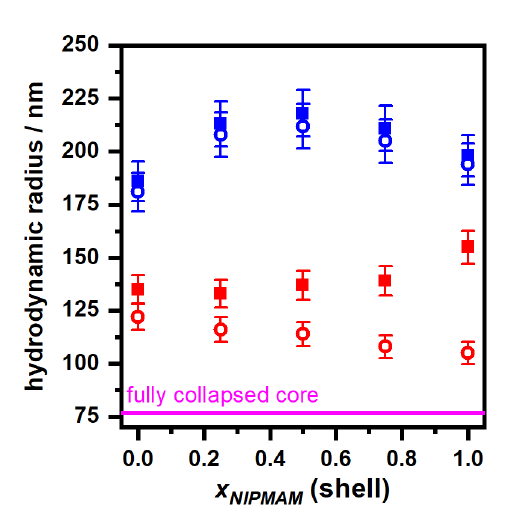
Figure 4. Plot of the hydrodynamic radii of all core-shell microgels in the fully swollen state (10 ◦ C, blue symbols) and in the collapsed state (55 ◦ C, red symbols) against the PNIPMAM fraction of the shell at pH = 7 (squares) and pH = 4 (circles). The magenta line indicates the hydrodynamic radius of the fully collapsed core (pH = 4, 55 ◦ C). All hydrodynamic radii were obtained from angle-dependent PCS